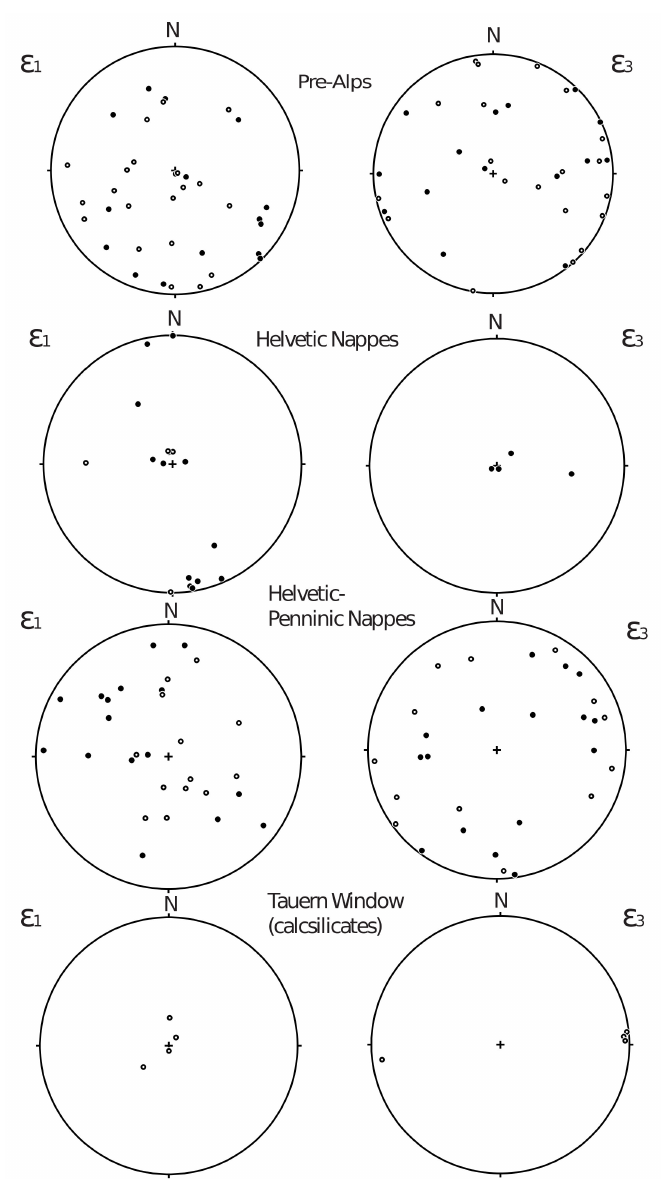
Figure 8. Lower hemisphere stereoplots of calcite strain data (e1 = shortening axes; e3 = extension axes) for different structural elements of the Alps. Key: filled circles are LPS fabrics, open circles are LNS